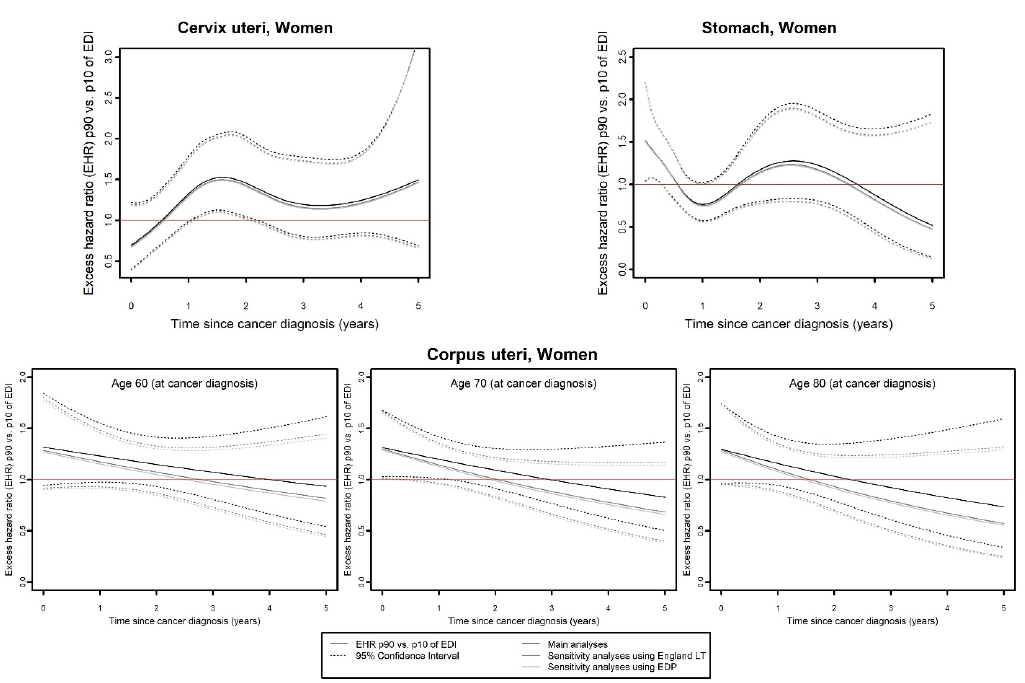
Figure 3. Excess mortality hazard ratio (EHR) between the 90th and the 10th percentile of the national distribution of EDI as a function of the time since cancer diagnosis, according to main analyses, sensitivity analyses using English life tables and sensitivity analyses using EDP data, for cancer sites for which all three analyses were concordant (same flexible model selected) and model showed an overall time-dependent effect of EDI on excess mortality hazard. For corpus uteri cancer, the effect of EDI on excess mortality was also age-dependent, therefore the results are presented for three values of age corresponding to the 25th, 50th, and 75th percentiles of the age distribution in the studied population with corpus uteri cancer. EDI: European Deprivation Index; EDP: French permanent demographic sample [Echantillon Démographique Permanent]; EHR: excess mortality hazard ratio; LT: life tables; p90, p10: 90th and 10th percentile of the national distribution of EDI. Table 1. The effect of deprivation (EDI) on cancer net survival for each cancer site, from the selected flexible model, according to main analyses, sensitivity analyses using English life tables (SA_Eng LT), and sensitivity analyses using EDP data (SA_EDP).